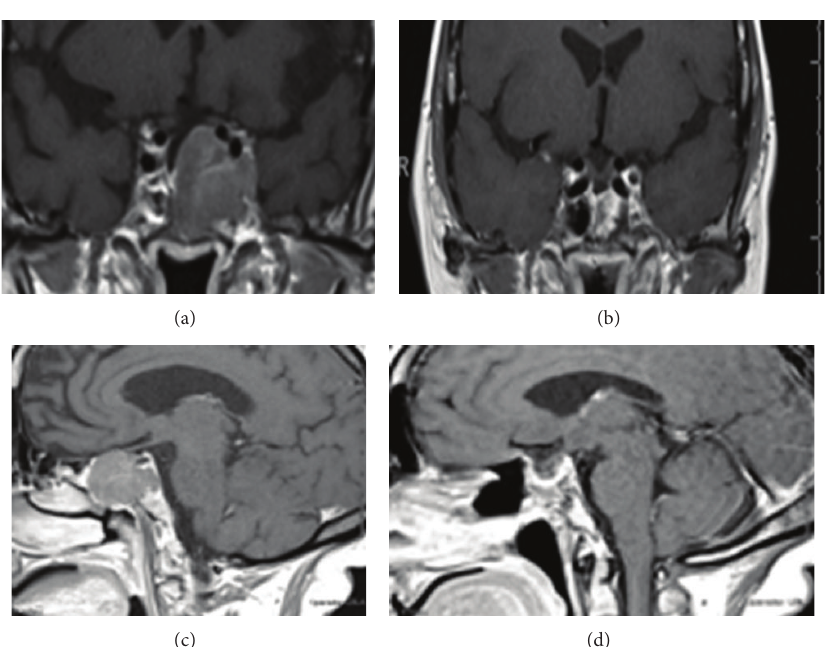
Figure 1: (a) Coronal image before the third surgery. (b) Sagittal image before the third surgery. (c) Coronal image after the third surgery. (d) Sagittal image after the third